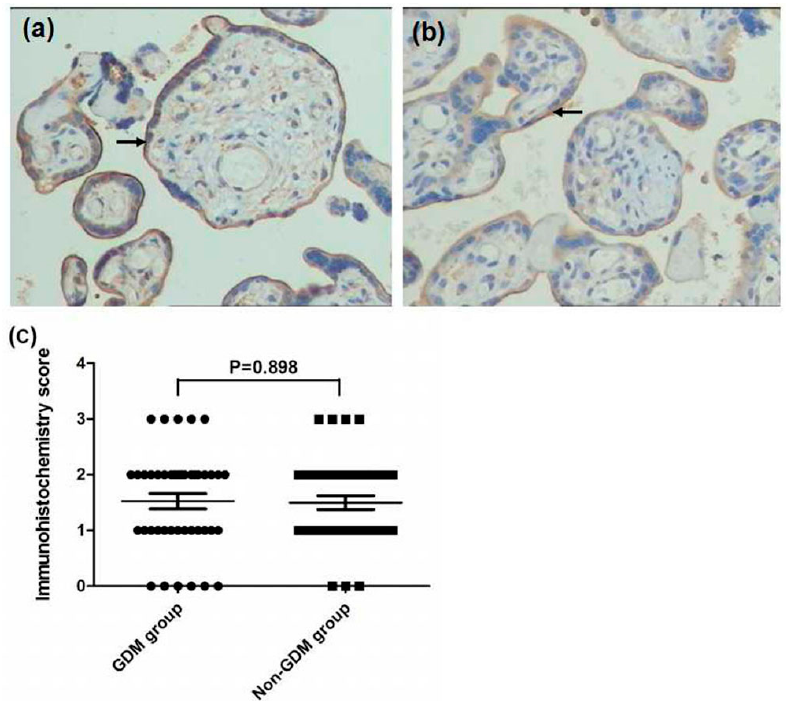
Figure 2. Immunohistochemistry images demonstrated that TfR1 was expressed on the membrane of maternal surface (as arrows) and there were no significant difference being found between the GDM group ( a ) and non-GDM group ( b ) (×200 magnification). No significant difference were foundin immunohistochemistry score between the two groups ( c , p = 0.898).